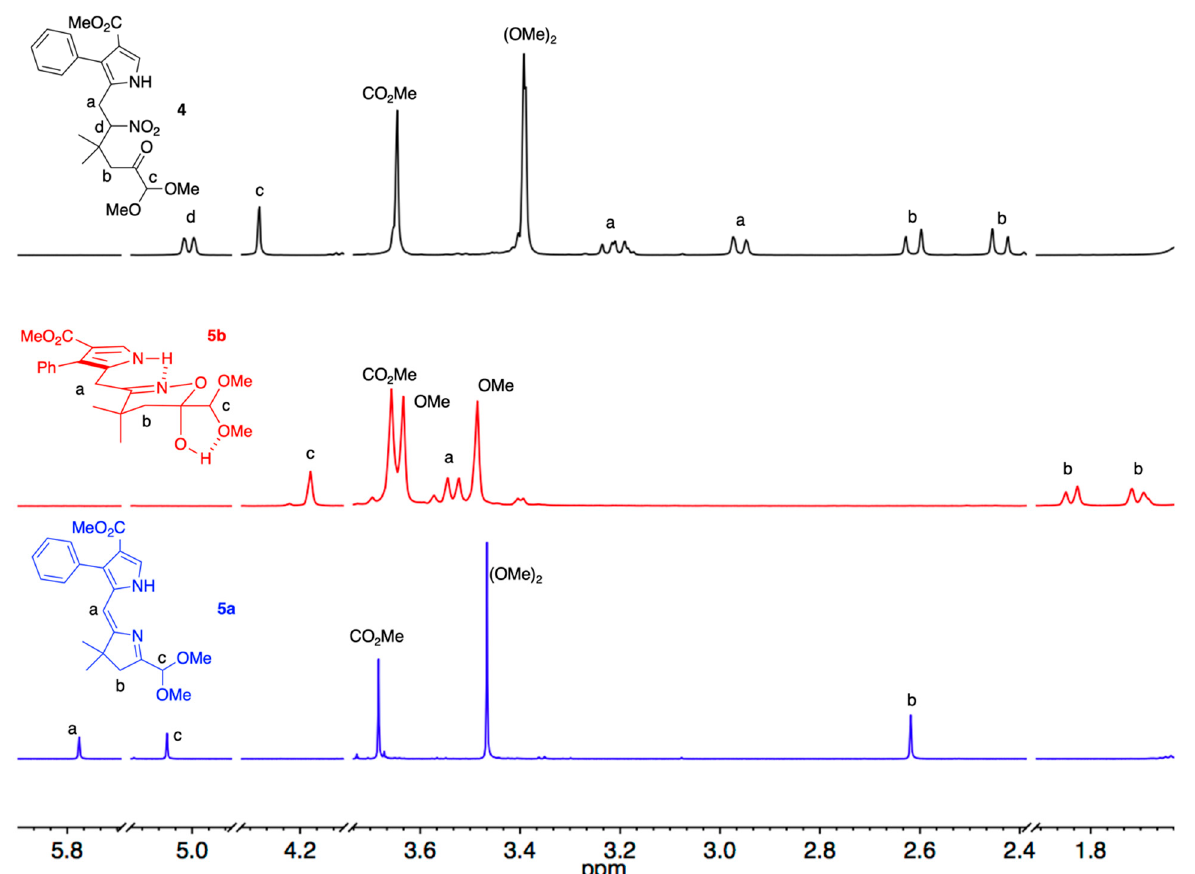
Figure 3. 1 H NMR spectra in CDCl 3 at room temperature of precursor 4 ( top ) and products 5b ( middle ) and 5a ( bottom ).